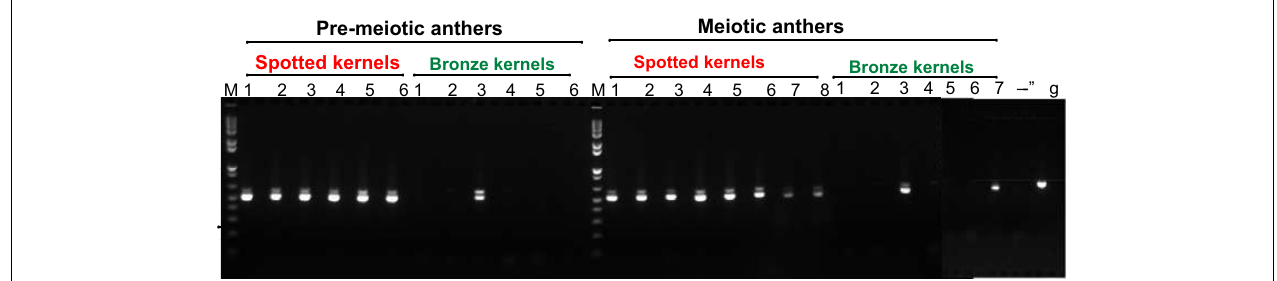
FIGURE 3 | RT-PCR assessment of mudrA transcripts from Mu killer and Mu active